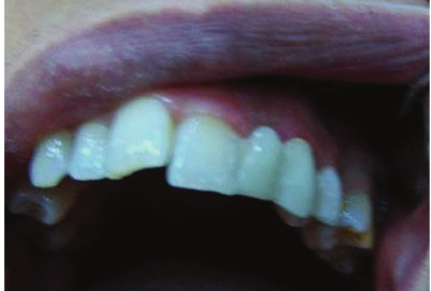
Figure 5: Frontal view of the final restoration.